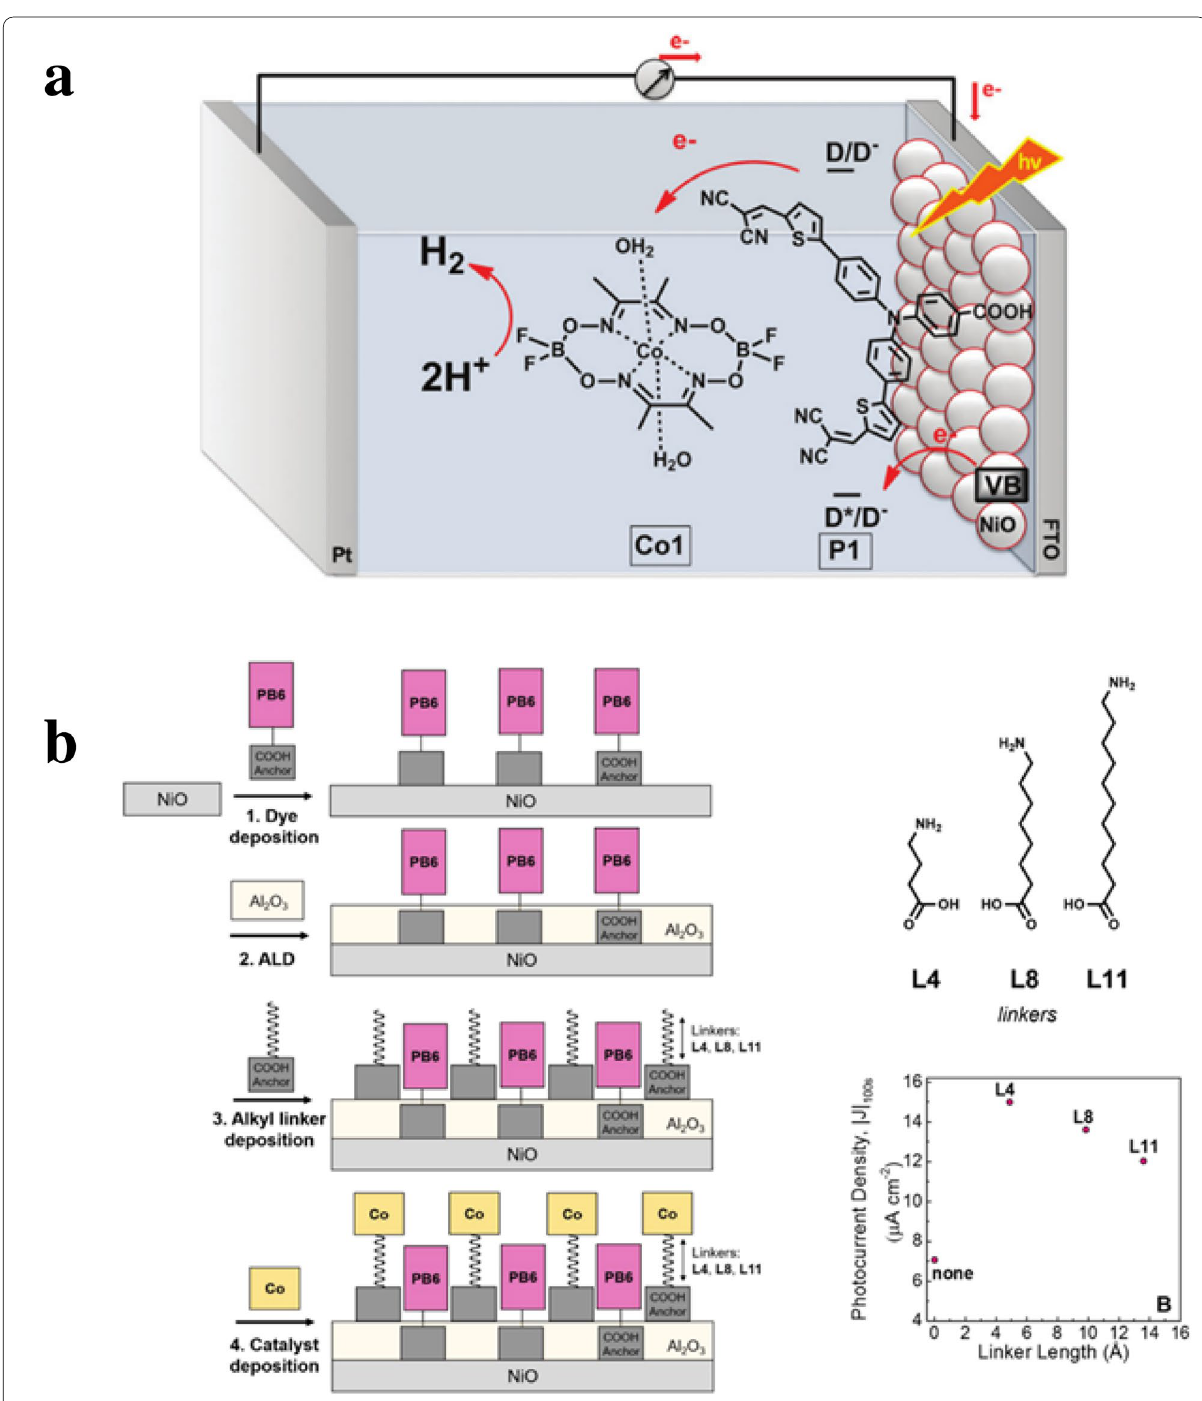
Fig. 3 a A NiO-based photocathode containing surface bound organic sensitizer (P1), and soluble Co-based proton reduction catalyst (Co1) [53]. b NiO photocathode architectures prepared using alkyl-linked catalysts and photocurrent density depending on the length of linkers. PB6: push– pull organic sensitizer, Co: proton reduction catalyst, L: the alkyl linkers [57]. Reproduced from Li et al. [53] with the permission of the Royal Society of Chemistry and Materna et al. [57] with permission from the American Chemical Society, source material available at https ://pubs.acs.org/doi/ full/10.1021/acsam i.0c052